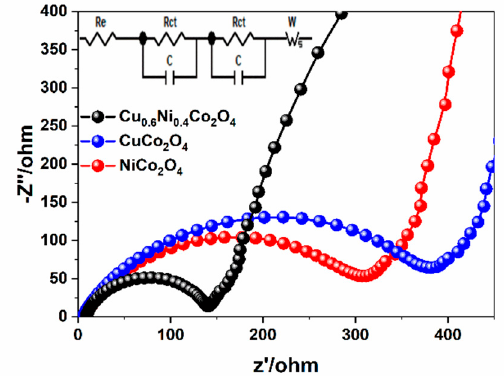
Figure 8. Nyquist plots for the three electrodes in the frequency range from 100 kHz to 0.01